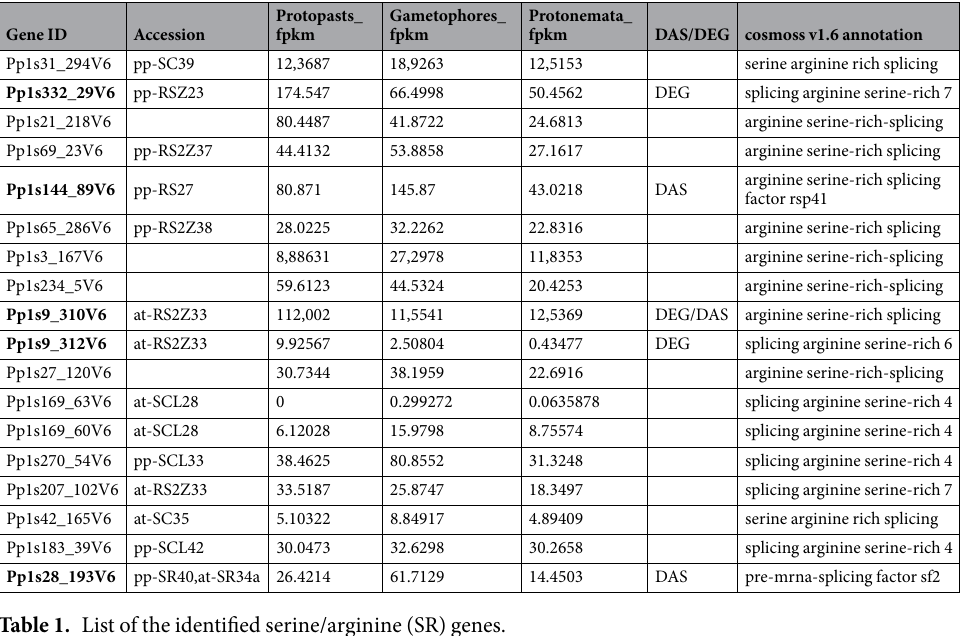
Table 1. List of the identified serine/arginine (SR)